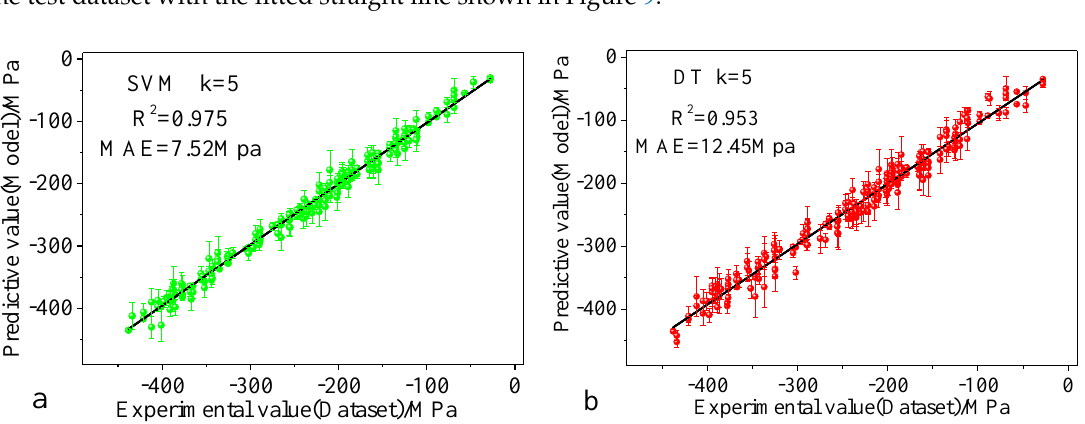
Figure 9. Comparison of the predicted residual stress values of support vector machine (SVM) and decision tree (DT) models with the experimental values: ( a ) SVM model 5-fold cross-validation results; ( b ) DT model 5-fold cross-validation results.